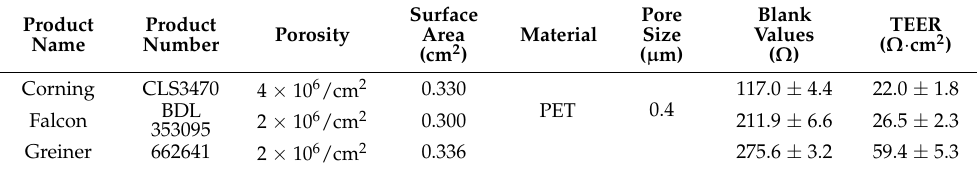
Table 2. Electrical resistance dependency on insert porosity. Blank values and TEER are presented as the mean ± SD, n = 3. PET, polyethylene